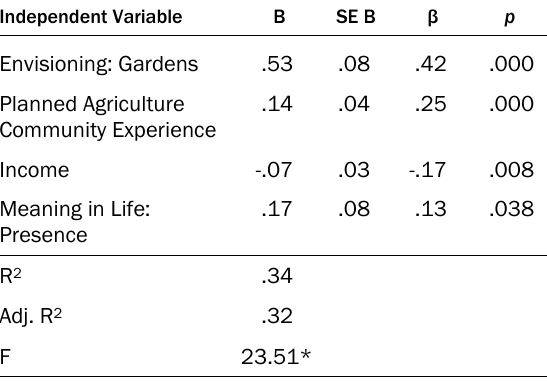
Table 11. Dependent Variable: Intrinsic